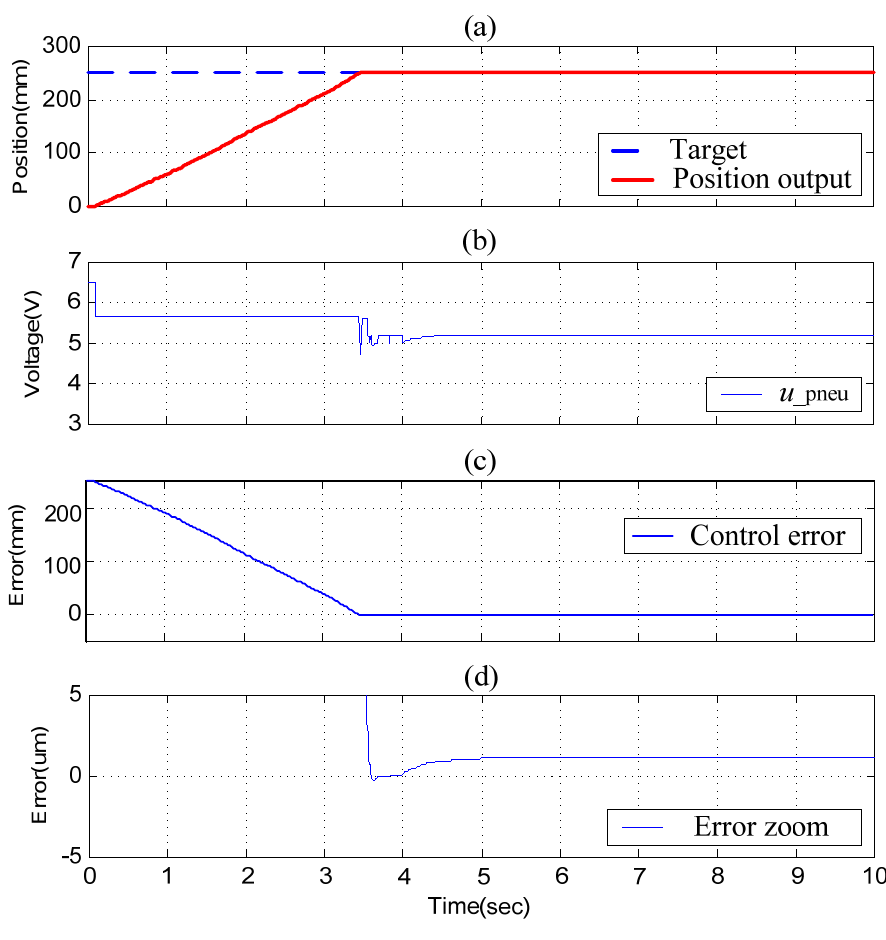
Figure 6. Experimental results of position control of the X-axial pneumatic actuator with stroke of 250 mm by SOFSMC: (a) position control response, (b) control signal, (c) control error, (d) error